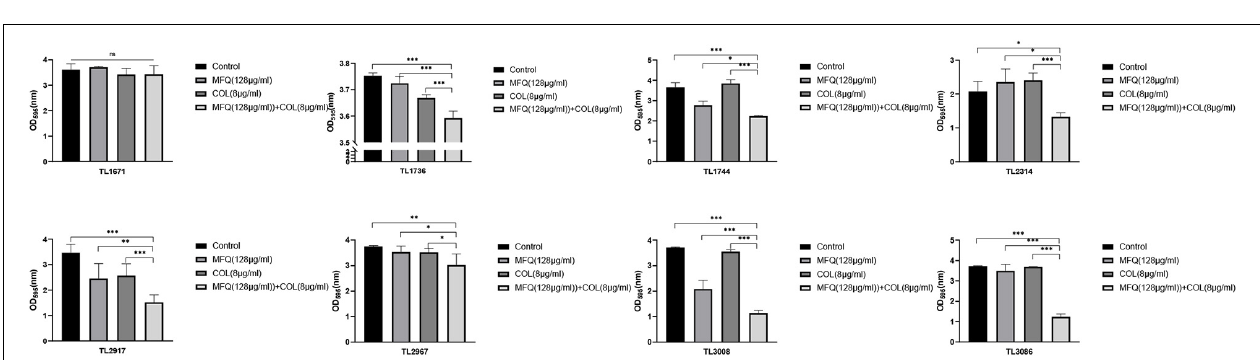
FIGURE 2 | Inhibitory effect of mefloquine combined with colistin on biofilm formation of Pseudomonas aeruginosa . The selected drug concentration was derived from the Checkerboard method with FICI < 0.5. P < 0.05 ( ∗ ), P < 0.01 ( ∗∗ ), and P < 0.001 ( ∗∗∗ ) analyzed by Student’s t -test. Mefloquine (MFQ) and colistin (COL).